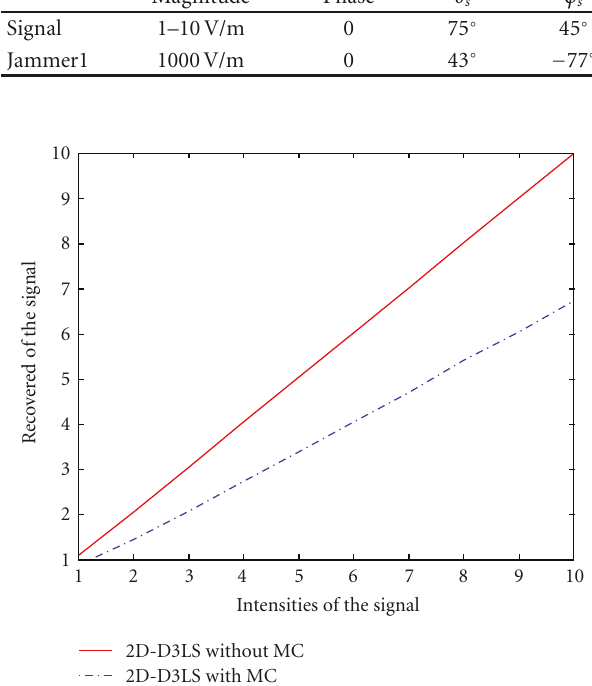
Figure 3: Recovered strength of the desired signal in the absence and presence of mutual